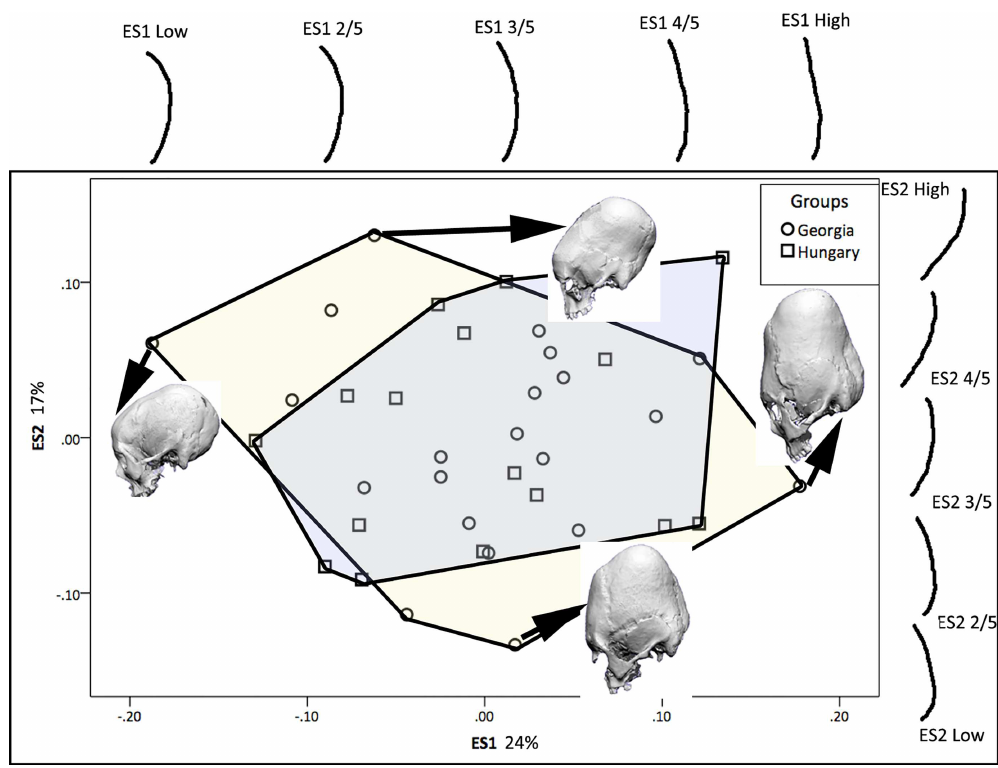
Fig 12. Eigenscores for the occipital outline plotted on ES1 and ES2 with convex hulls highlighting each group, also showing shape changes along the first and second morphospaces, and example crania demonstrating the